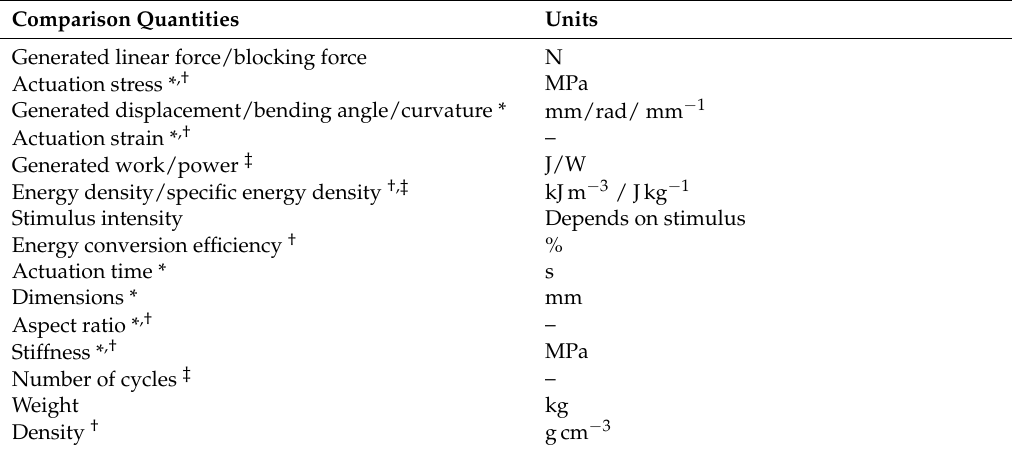
Figure A2. Comparison of the actuators based on the fabrication principles, with corresponding references: the colors represent the type of transducer. ( a ) Aspect ratio as a function of the minimal dimension. ( b ) Minimal dimension as a function of the transducer. ( c ) Stiffness as a function of the minimal dimension. The same figure without the references is presented and discussed in Figure 12. Table A1. Comparison criteria for soft actuators to consider for the design and characterization of programmable soft robots, in addition to their kinematics capabilities: the solutions reviewed are compared based on these criteria. * Quantities used for the quantitative comparisons. † Normalized quantities, which do not depend on the actuator dimensions. ‡ Quantities rarely reported, making a systematic comparison of the actuators